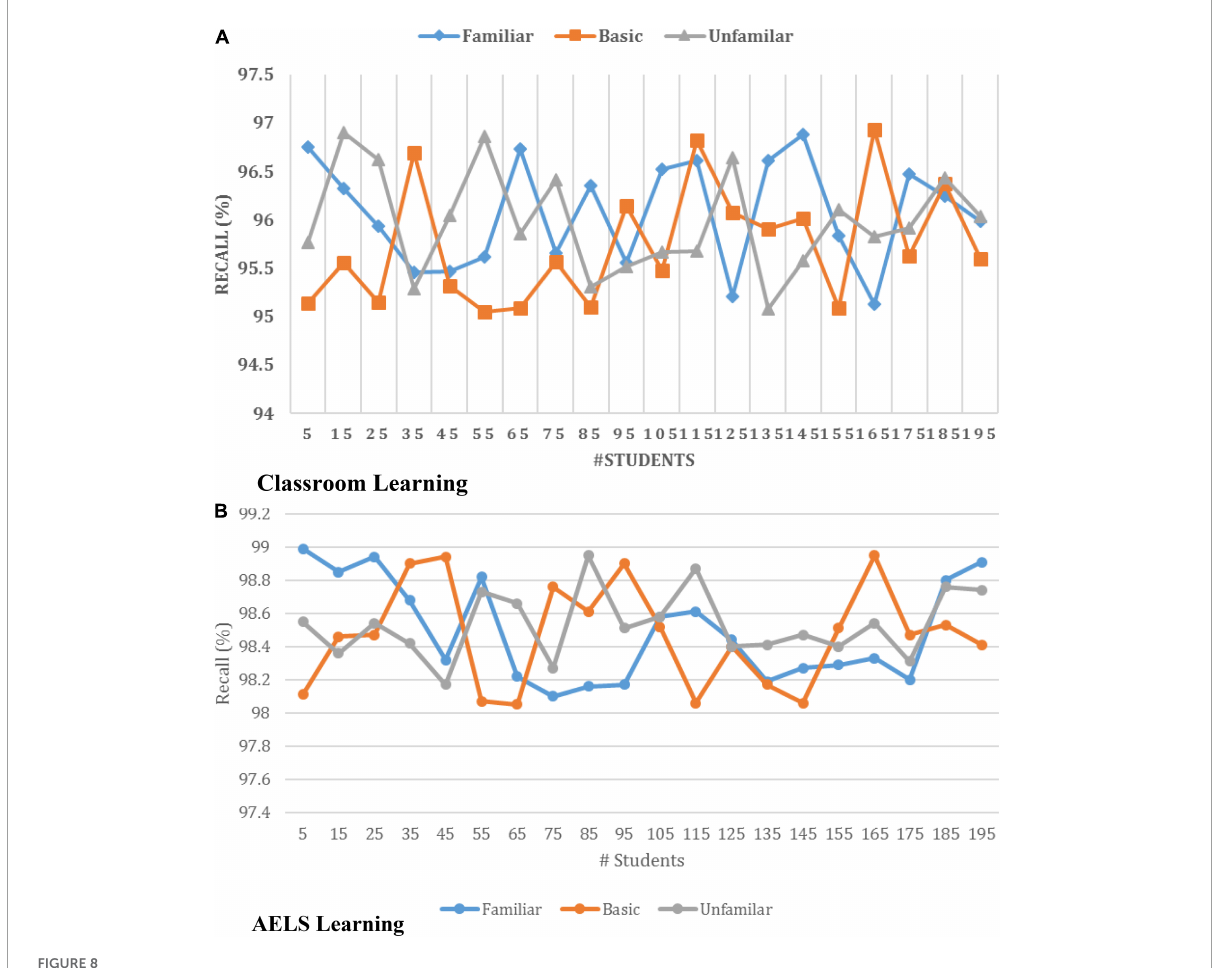
FIGURE8 Recall Analysis of (A) classroom and (B) AELS